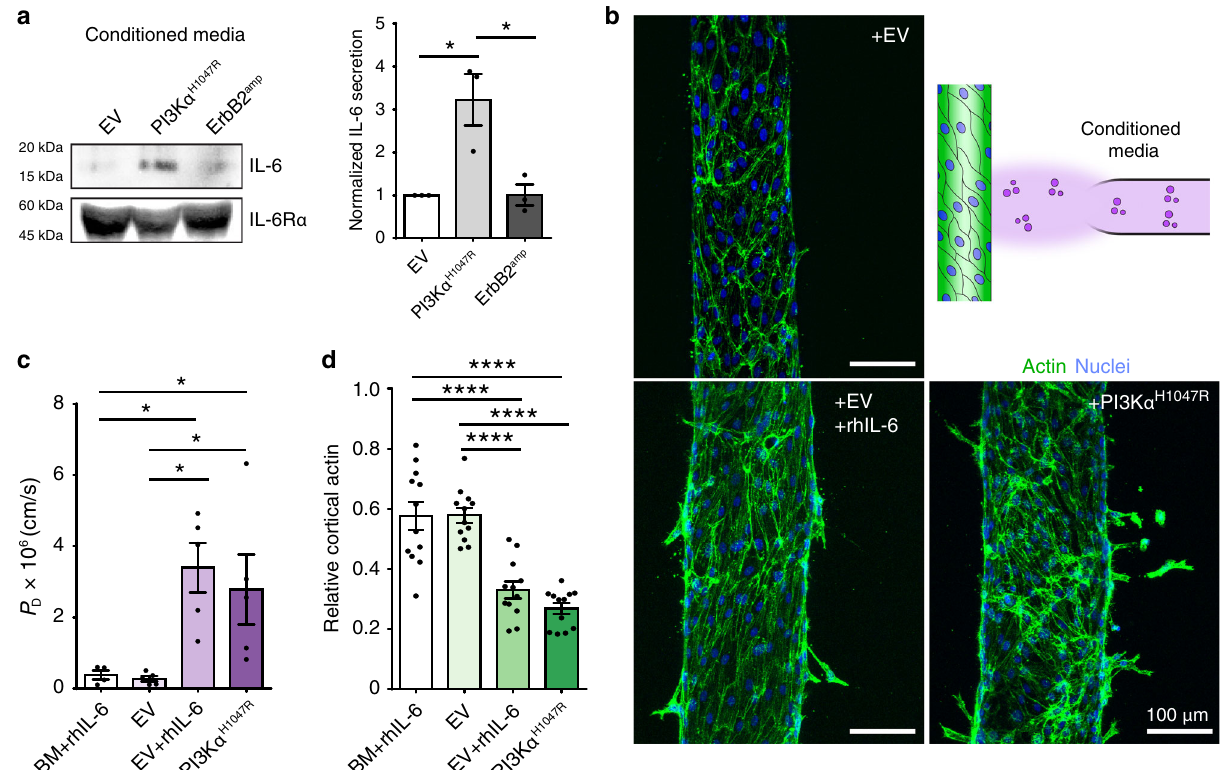
Fig. 4 PI3K α H1047R increases IL-6 secretion to drive vascular dysfunction and remodeling. a Representative western blot and associated quanti fi cation of conditioned media from EV, ErbB2 amp , and PI3K α H1047R ducts immunoblotted for human IL-6 and IL-6R α ( n = 3 western blots from three independent experiments). b Top right: Experimental schematic of endothelial vessel-conditioned media setup. Maximum intensity projection micrographs of endothelial vessels treated overnight with EV, EV + recombinant human IL-6 (rhIL-6) (200 ng/ml), or PI3K α H1047R conditioned media; phalloidin (green), DAPI (blue). c Diffusive permeability P D ( n = 4, 5, 5, 5 vessels examined across three independent experiments; one-way ANOVA with Bonferroni